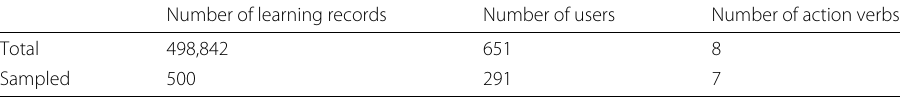
Table 6 Test data